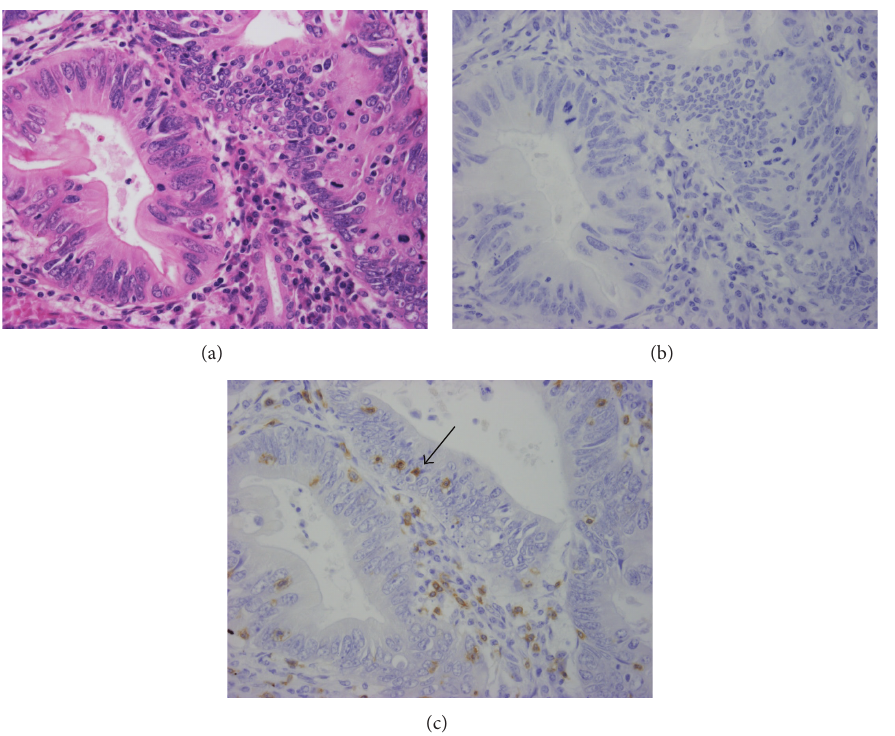
Figure 2: Extrahepatic cholangiocarcinoma with scant IgG4 reactions. Hematoxylin and eosin stain of inflammatory cells in the stroma of adenocarcinoma (a). Immunohistochemistry identified no IgG4-positive cells (b), but CD8-positive T cells were scattered throughout the stroma and cancerous nests (arrows, (c)).